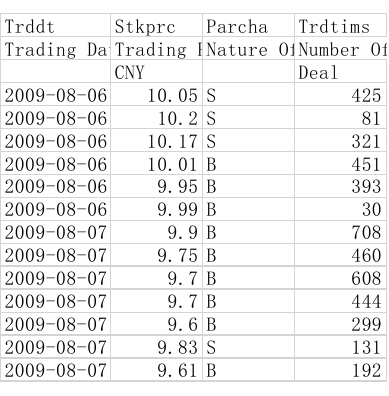
Figure 1. Printout from one of the brokers’ tapes.